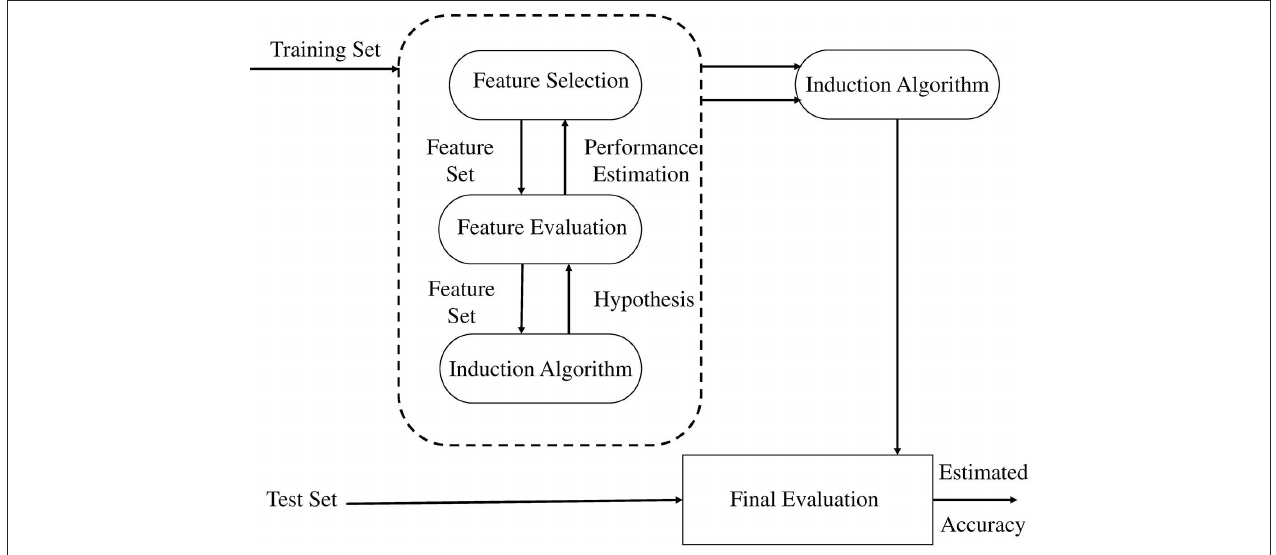
FIGURE 5 | The wrapper approach to feature subset selection. The induction algorithm is used as a “black box” by the subset selection algorithm (Kohavi and John, 1997).